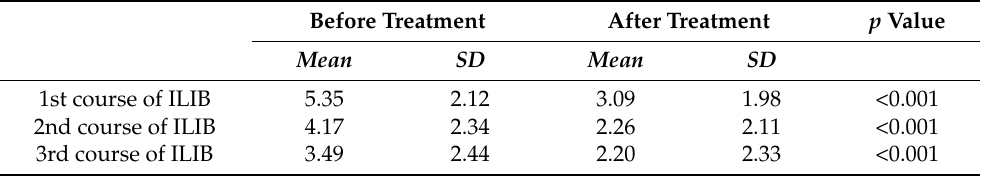
Table 2. The Visual Analogue Scale (VAS) of patients with musculoskeletal pain before and after receiving ILIB treatment.